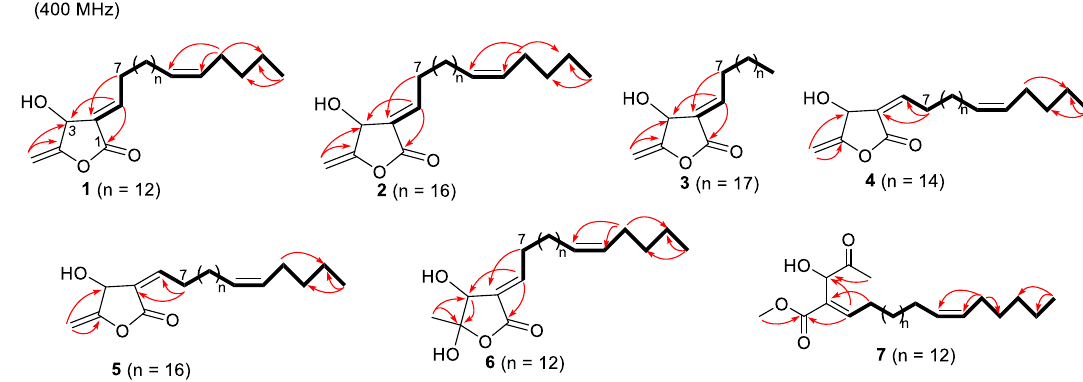
Figure 2. Selected HMBC correlations (arrows in red), COSY connectivities (bold lines) for compounds 1−7.